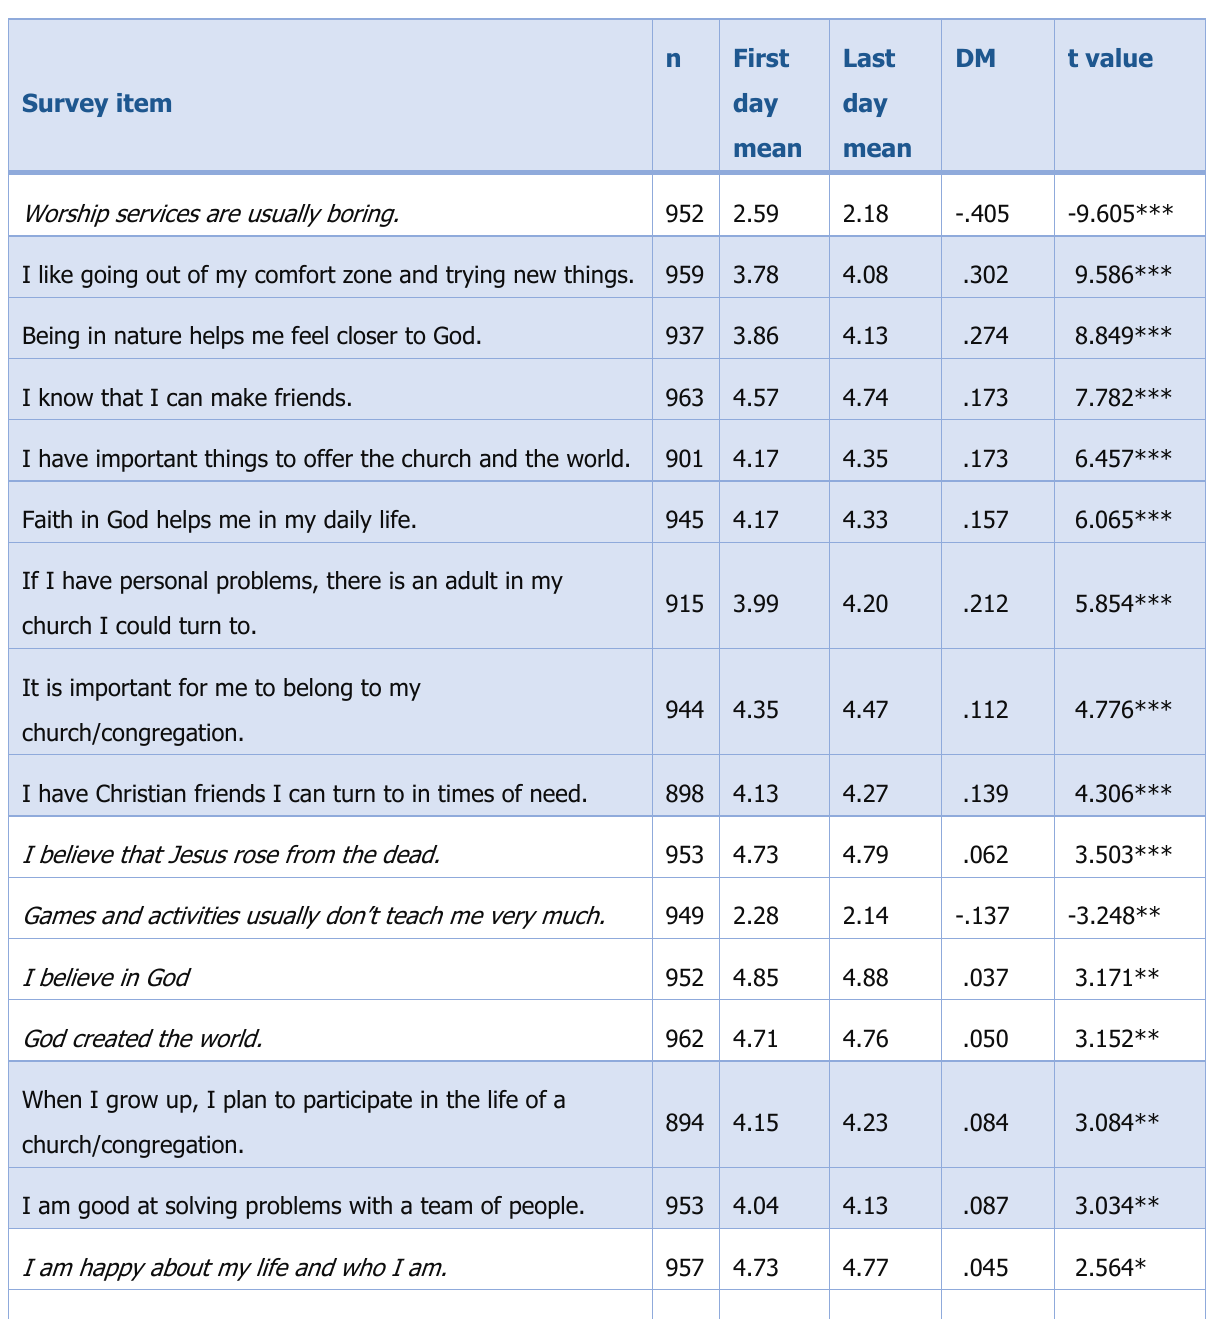
Table 1. Comparison of First- and Last-Day Mean Responses for 17 Identical Survey Items Survey item